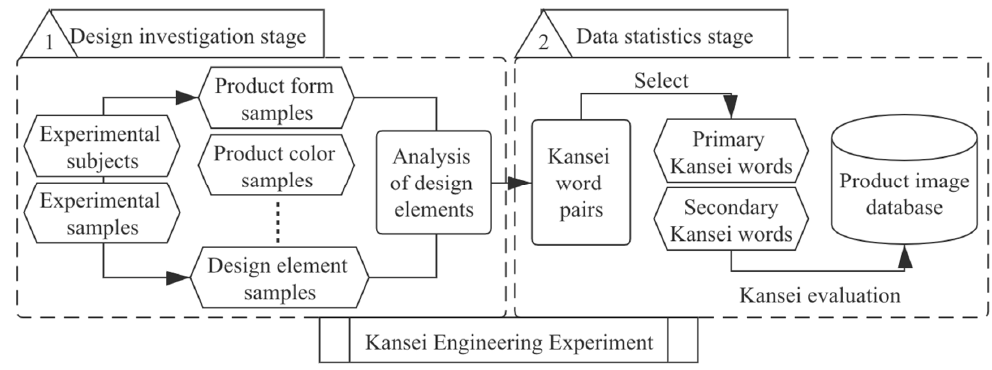
Figure 4. The Kansei Engineering experiment process of product image design.